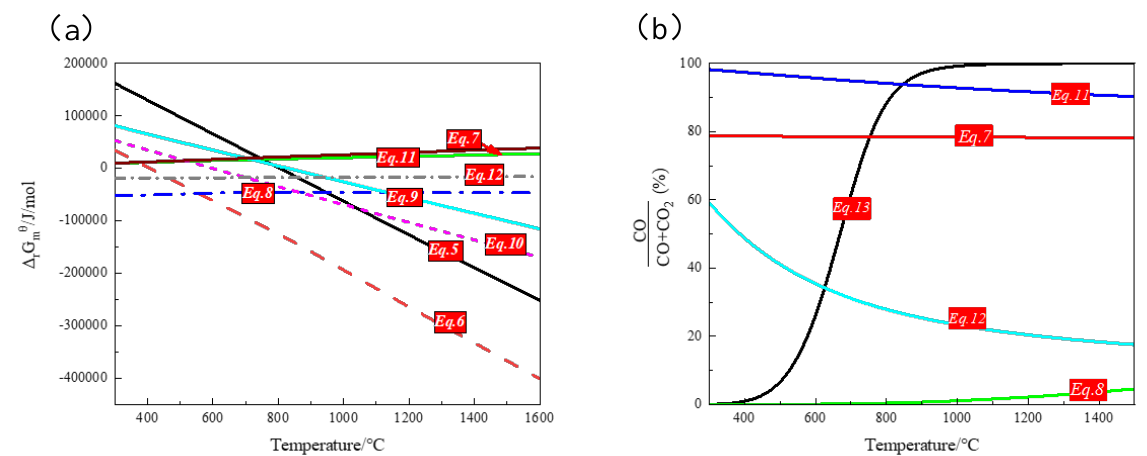
Figure 8. The correlation of the standard free energy ( ∆ r G m θ ) with reaction temperature for Equations (5–12). ( a ): The standard free energy versus reaction temperature; ( b ): Gas-phase equilibrium of Equations (7,8,11,12) reduced by CO).